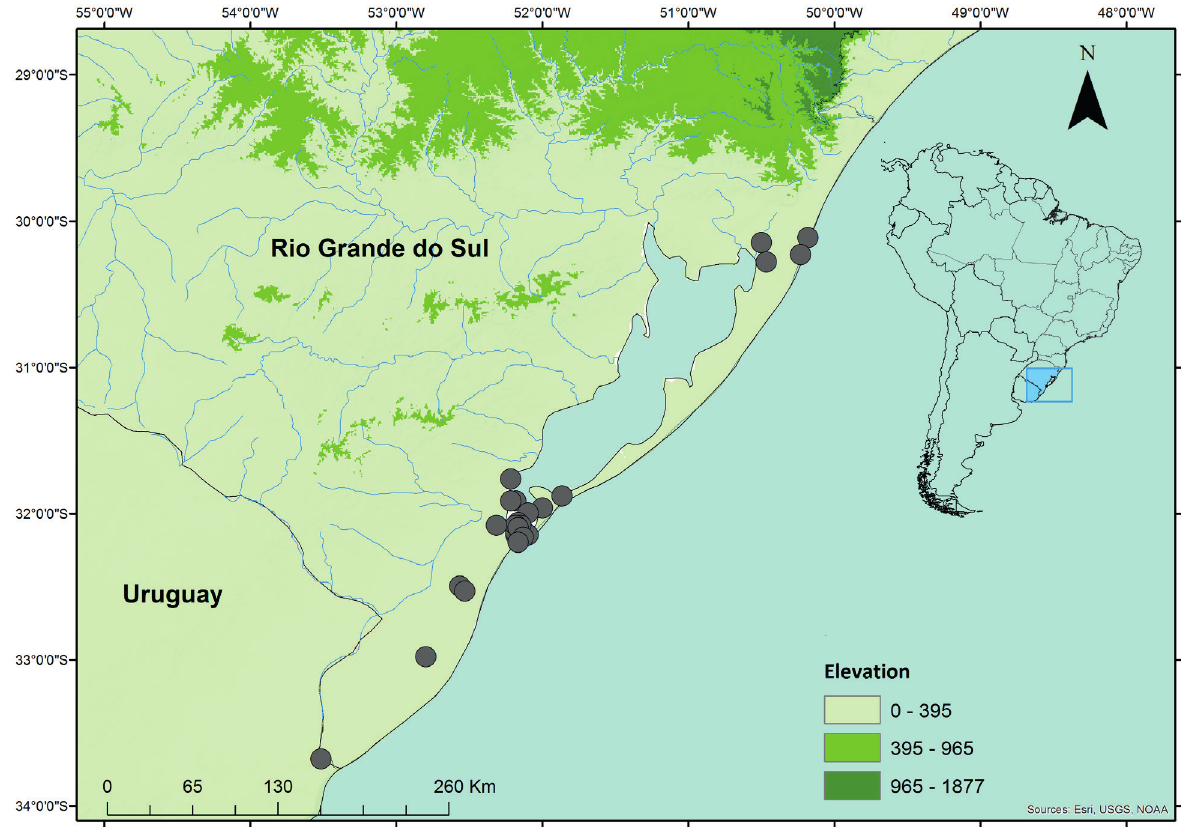
Figure 2 - location of the sampled sites at southernmost Brazilian coast, Rio grande do Sul